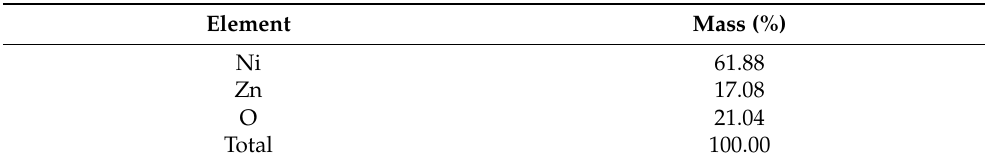
Figure 2. EDS images of the ( a ) Ni 0.6 Zn 0.4 O, ( b ) Ni, ( c ) Zn, ( d ) O, ( e ) SEM images and ( f ) Particle size distribution of Ni 0.6 Zn 0.4 O. Table 1. Element of Ni 0.6 Zn 0.4 O samples.